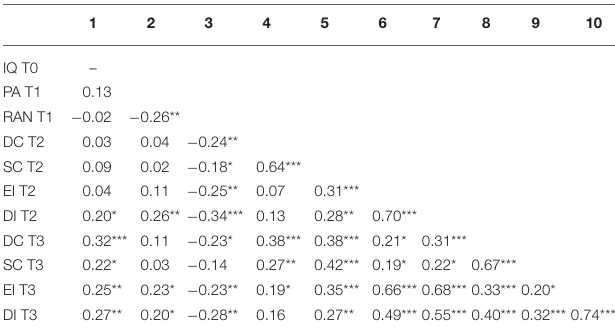
TABLE 3 | Correlation coefficients for all